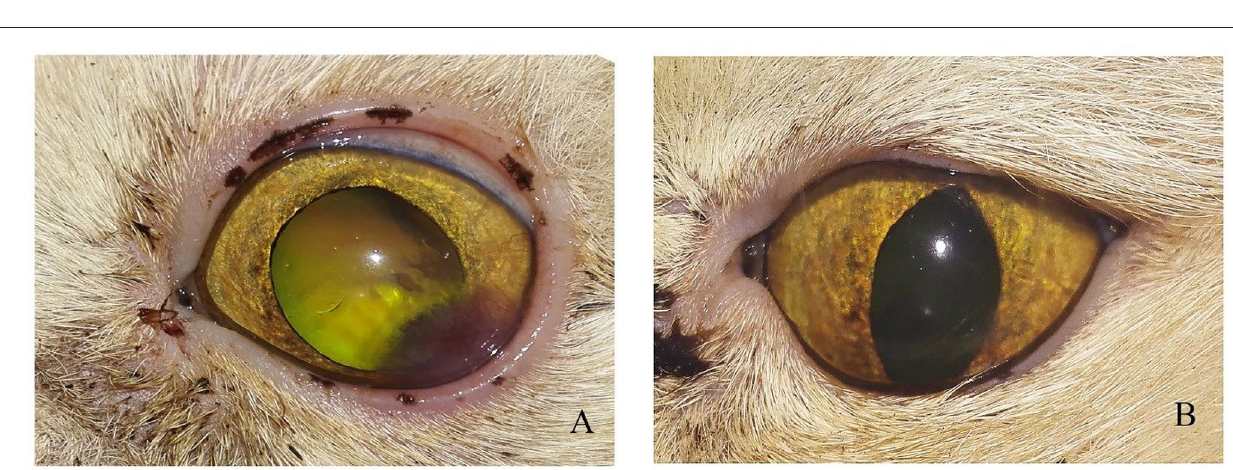
Frontiers in Veterinary Science |